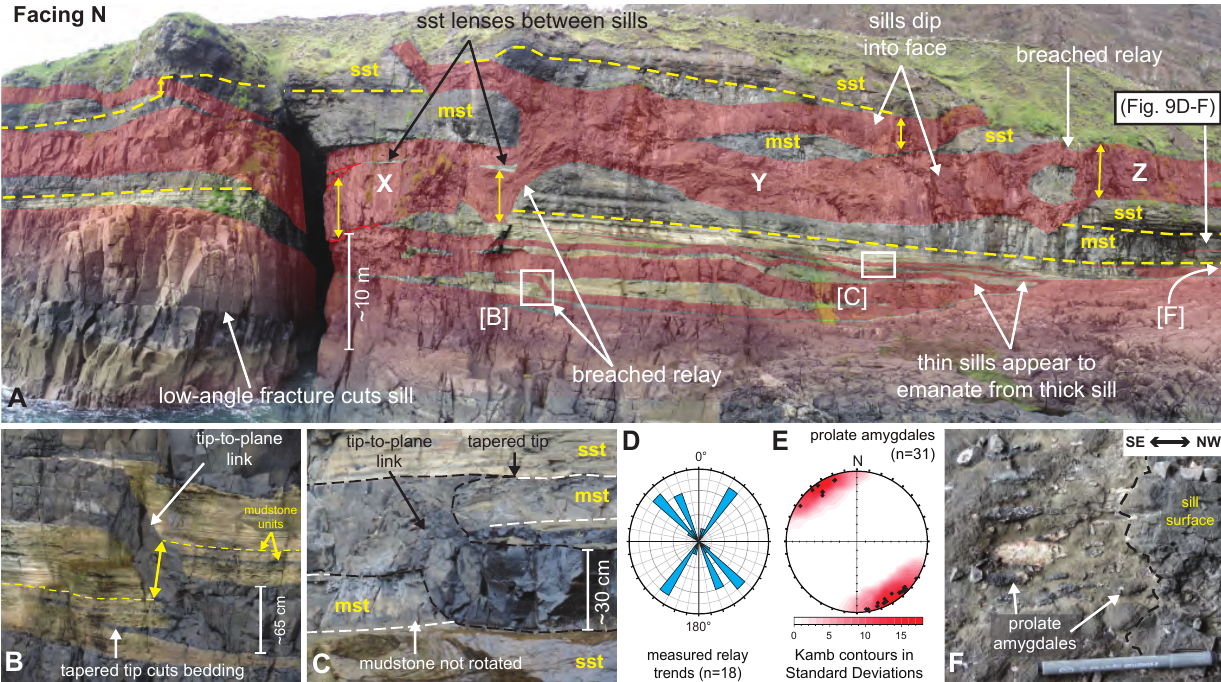
Figure 5: [A] Thin sill network in the Neist Point study area, sills display consistent near-vertical uplift of host rock (yellow arrows). Right-(NE)-stepping linked segments (X-Y-Z) transgress through sandstone (sst) and mudstone (mst) units at the tens-of-metre scale. [B]–[C] examples of linked offset segments in sandstone: [B] tip-to-plane link, left-(SW)-stepping; [C] tip-to-plane link, left-(SW)-stepping; host rock is not rotated within these relays. [D] Rose diagram showing relay trends in the study area, predominant trends are NW–SE and NE–SW; bins are split into 10°intervals and each bin represents 1 measurement. [E] Colour contoured equal-area lower- hemisphere stere- onet of prolate amygdales at upper sill contact, plotted as lineations (measured as rake). [F] Example of prolate amygdales plotted in [E]. (Unannotated photos available in Supplementary File 1, data available in Supplementary File